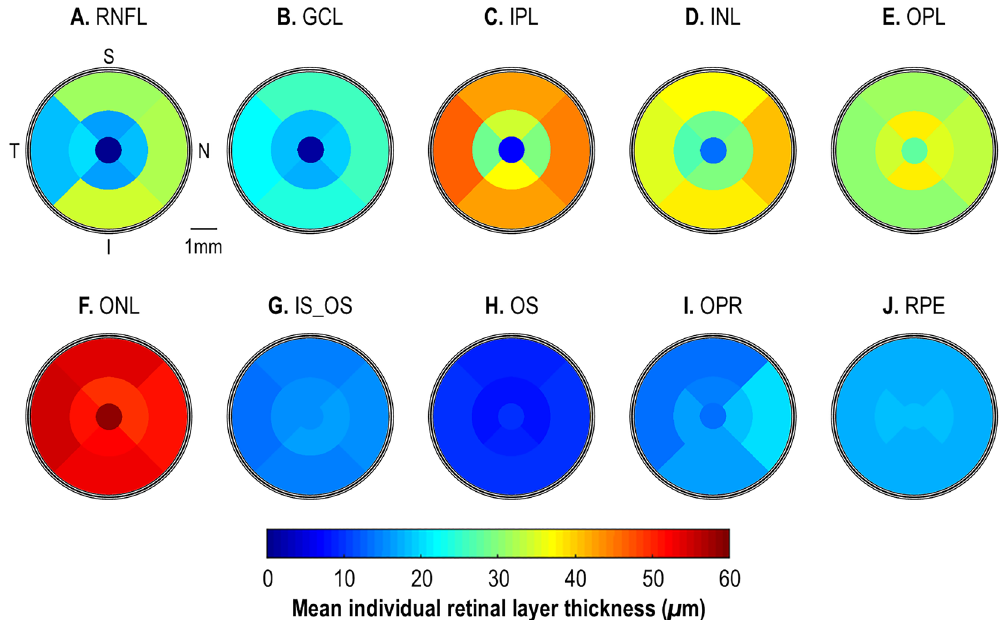
Figure 4. ETDRS color map summarizing the mean individual 10 retinal layer thicknesses for all common marmosets (n = 13) at baseline. S = Superior; T = Temporal; N = Nasal; and I = Inferior. RNFL = retinal nerve fiber layer; GCL = ganglion cell layer; IPL = inner plexiform layer; INL = inner nuclear layer; OPL = outer plexiform layer; ONL = outer nuclear layer; IS_OS = inner segments/outer segments layer, OS = outer segment, OPR = outer segment photoreceptor + subretinal virtual space, and RPE = retinal pigment epithelium. ETDRS color map summarizing the average baseline thickness for each individual retinal layer ( A – J ) for all marmosets (n = 13).